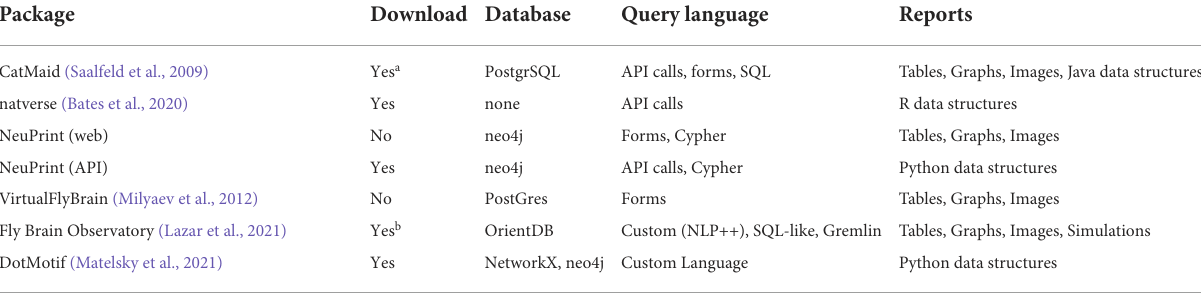
TABLE 1 Different querying options for